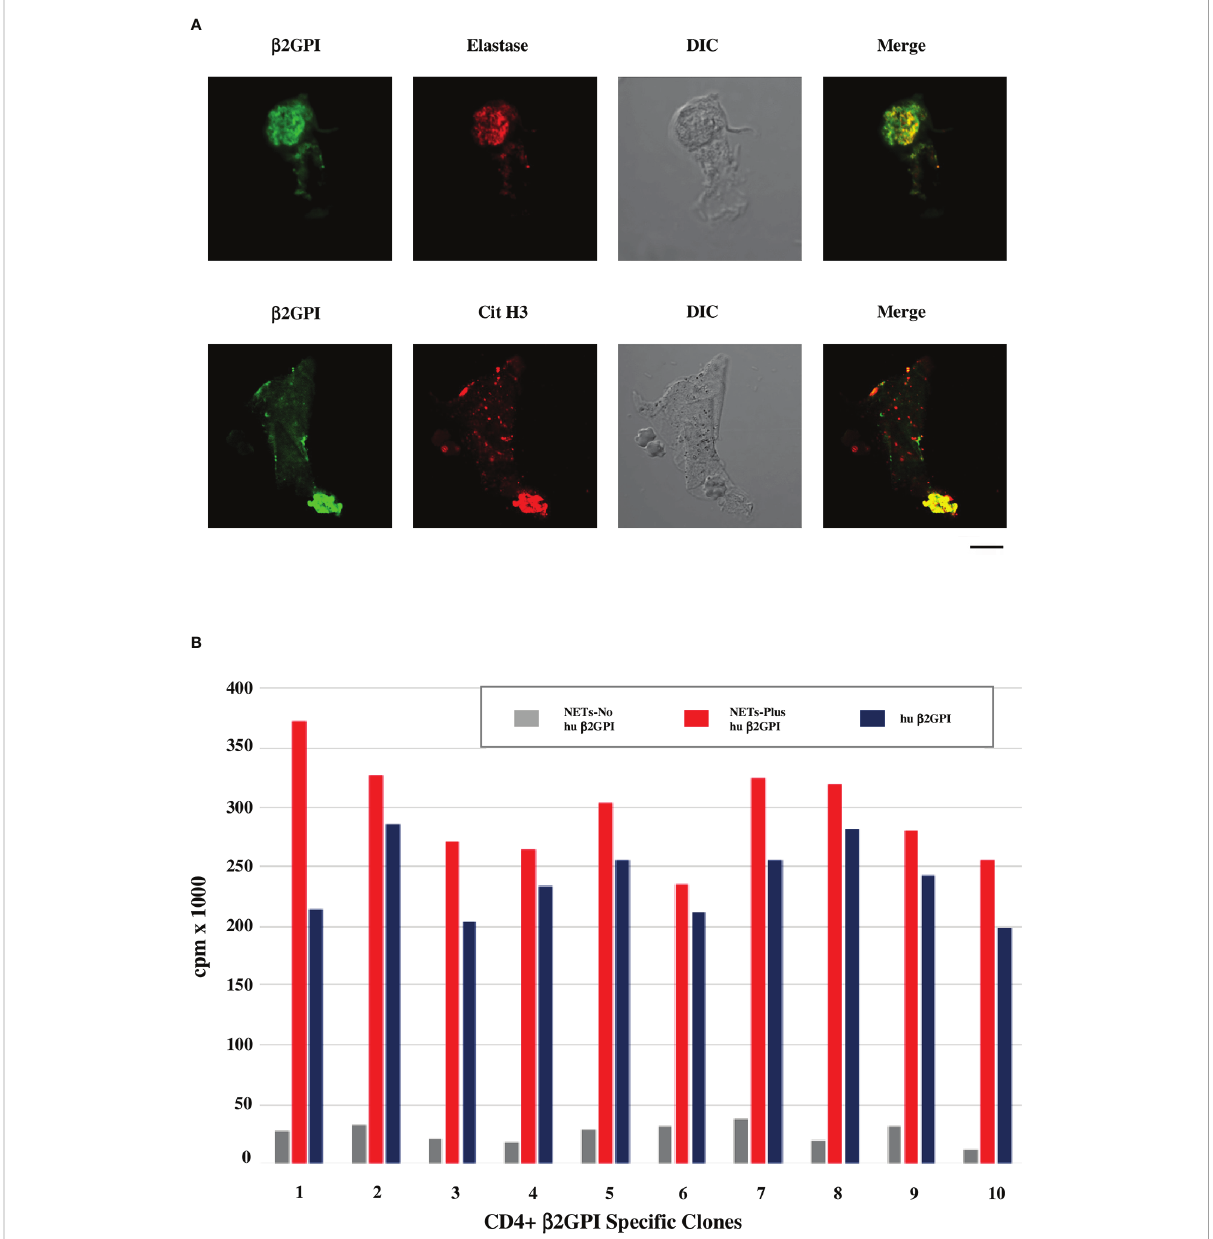
FIGURE 1 b 2GPI co-localizes with NET markers and b 2GPI-containing NETs stimulate proliferation of SLE-APS derived T cell clones. (A) Confocal microscopic analysis of human neutrophils cultured in media with human AB serum and stimulated with PMA for production of NETs. Green staining identi fi es b 2GPI, detected by MBB2 antibody (50), red staining identi fi es elastase by rabbit polyclonal anti-neutrophil elastase antibodies (Abcam) in the upper panel or citrullinated histone H3 (Cit H3) by IgG monoclonal anti-citrullinated histone H3 antibodies (LS-Bio) in the lower panel. Differential Interference Contrast (DIC) was applied as a non-destructive contrast enhancing technique to locate a speci fi c area of interest in the specimen. Brie fl y, human neutrophils were puri fi ed from peripheral blood of healthy donors (EasySep Human Neutrophil isolation kit, Stemcell Technologies) and cultured in medium RPMI 1640 with 5% human serum (Sigma Aldrich) as source of b 2GPI, or in b 2GPI-free medium (RPMI 1640 in the absence of any source of b 2GPI). The cells were stimulated by 100nM PMA for 2h at 37°C for the production of NETs and analyzed for the presence of b 2GPI by IF, using the human MBB2 MoAb IgG against D1- b 2GPI (50). Co-localization of b 2GPI with NET markers, such as elastase and histone H3, was investigated by confocal microscope (Zeiss LSM700 from Carl Zeiss). Alexa Fluor 488- and 555-labeled secondary antibodies were used: Alexa Fluor ™ 488-Goat anti-Mouse IgG (H+L) Cross-Adsorbed Secondary Antibody and Alexa Fluor ™ 555- Goat anti-Rabbit IgG (H+L) Cross-Adsorbed Secondary Antibody (Life Technologies). Scale bar 10 mm. (B) Proliferative response of SLE-APS patient derived b 2GPI-speci fi c T-cell clones to NETs, containing or not human b 2GPI, or to human puri fi ed b 2GPI alone (10 nM). Human b 2GPI was puri fi ed as previously described (51). T-cell clones were derived from the atherosclerotic plaques of the patients, as previously described (4, 5). Further methodological details are reported in the Supplementary